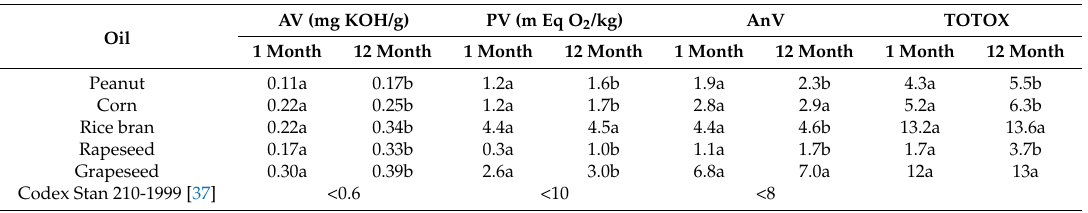
Table 1. Changes in the acid (AV), peroxide (PV), and anisidine (AnV) values and TOTOX of the selected oils between the 1st and 12th months of